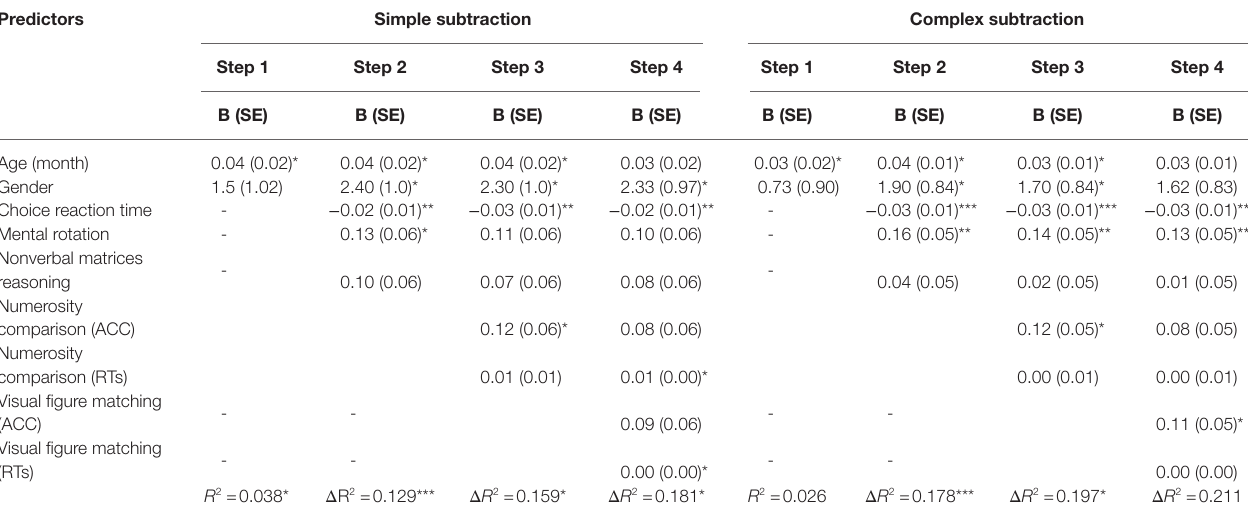
TABLE 5 | Results from hierarchical regression analyses for the relations of figure matching and arithmetic computation (simple subtraction and complex subtraction) after controlling for age/gender (step 1), general cognitive processes (step 2) and numerosity comparison (step 3).